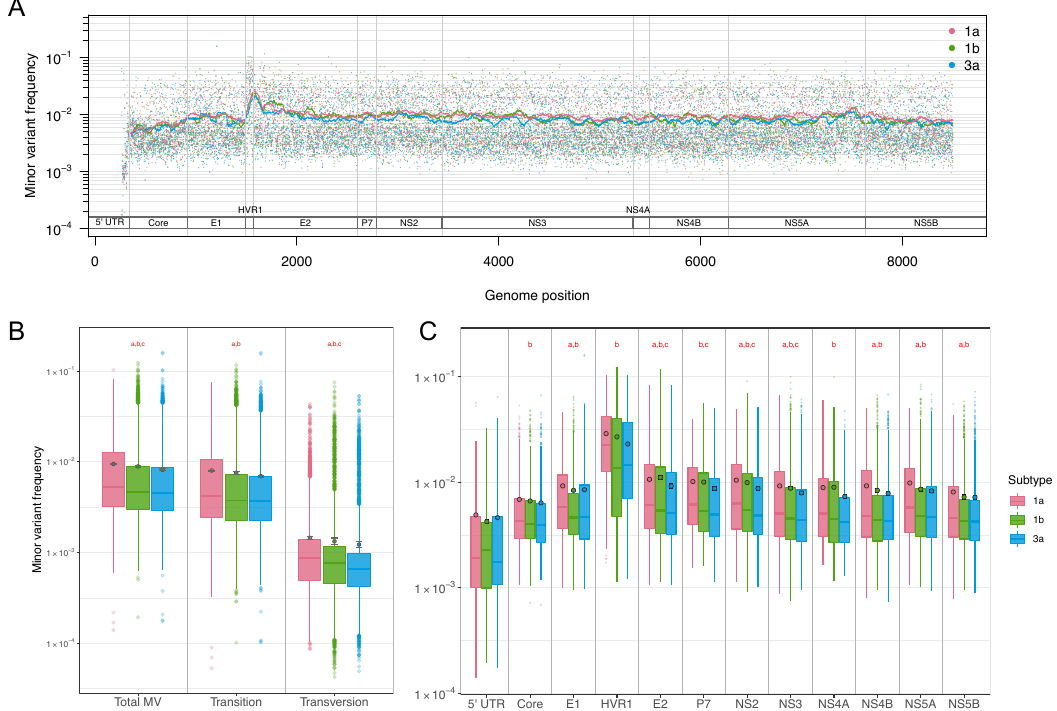
Figure 2. Within-host minor variant frequencies (MVFs) of HCV subtype 1a, 1b, and 3a. ( A ) MVFs across the genome with a 100-base rolling average, ( B ) a box plot of MVFs for total, transition, and transversion mutations, and ( C ) a box plot of MVFs per genomic region. Circles in ( B , C ) represent the means with standard errors. Letters in ( B , C ) represent statistically significant differences between subtype 1a and 1b (a), subtype 1a and subtype 3a (b), and subtype 1b and subtype 3a